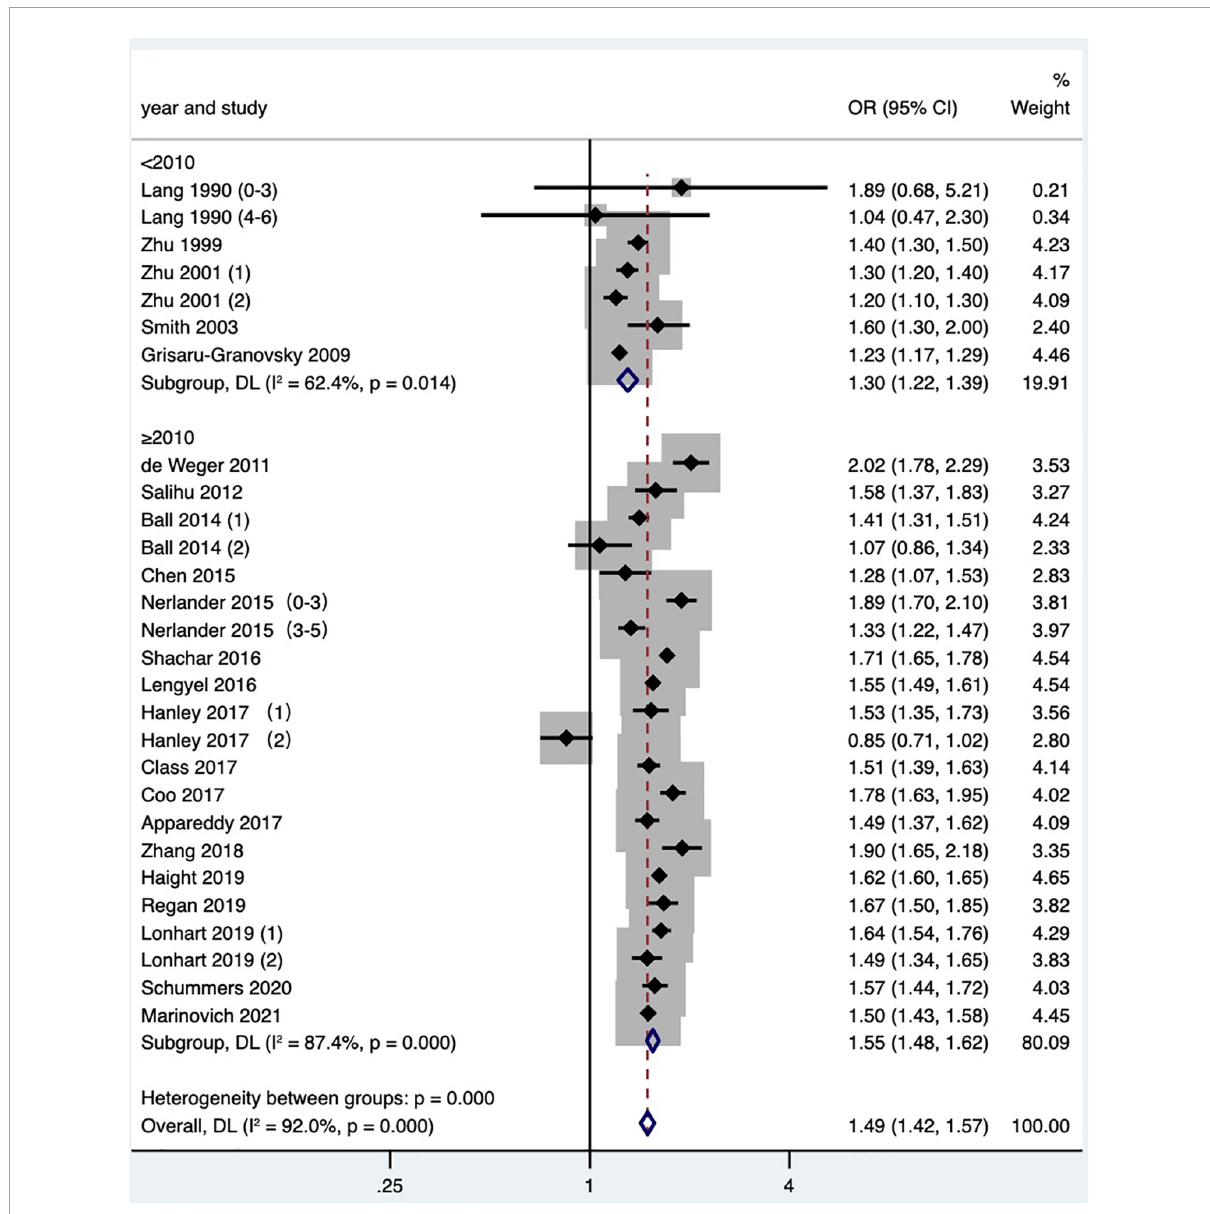
FIGURE9 Subgroup analysis of the effect of short IPI on preterm birth. Lang et al. (14) (0–3) referred to the IPI of 0–3 months vs. 18–23 months; Lang et al. (14) (4–6) referred to the IPI of 4–6 months vs. 18–23 months; Zhu et al. (15) (1) was white data, Zhu et al. (15) (2) was black data; Nerlander et al. (27) (0–3) referred to the IPI of 0–3 months; Nerlander et al. (27) (3–5) referred to the IPI of 3–5 months; Ball et al. (24) (1) was non-matching data, and Ball et al. (24) (2) was within-mother matching data; Hanley et al. (36) (1) was non-matching data, and Hanley et al. (36) (2) was within-mother matching data; Lonhart et al. (43) (1) was non-Hispanic whites data, and Lonhart et al. (43) (2) was non-Hispanic blacks